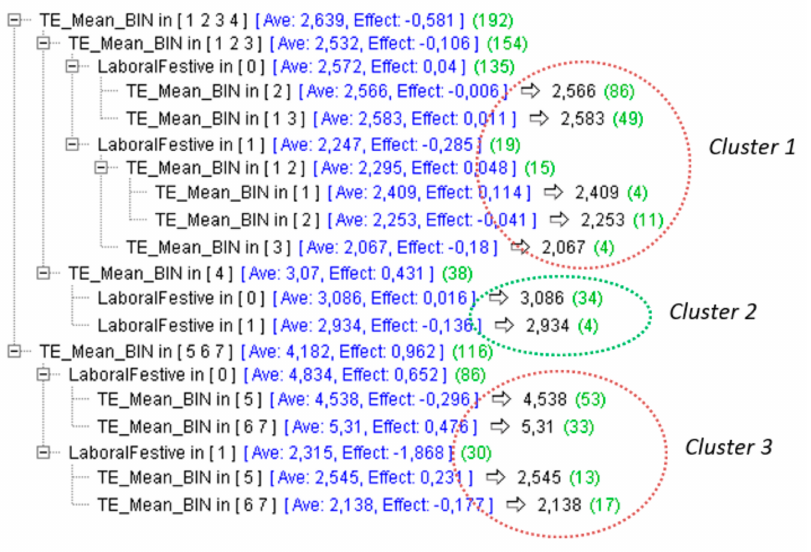
Figure 4. Set of rules for the clustering of the sample with the objective of average active power compressor versus temperature and work or